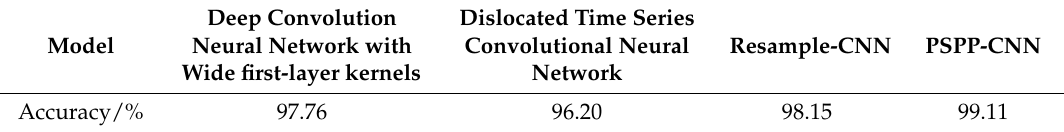
Table 9. Fault diagnosis result using other proposed CNN-based methods.